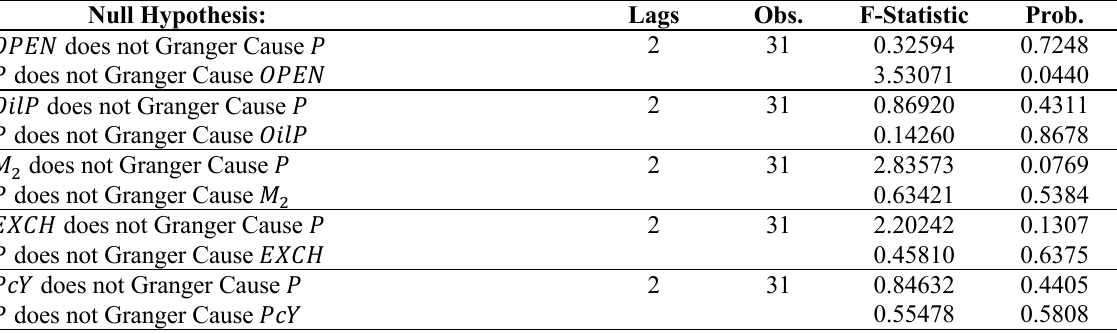
Table 5: Granger Causality Test